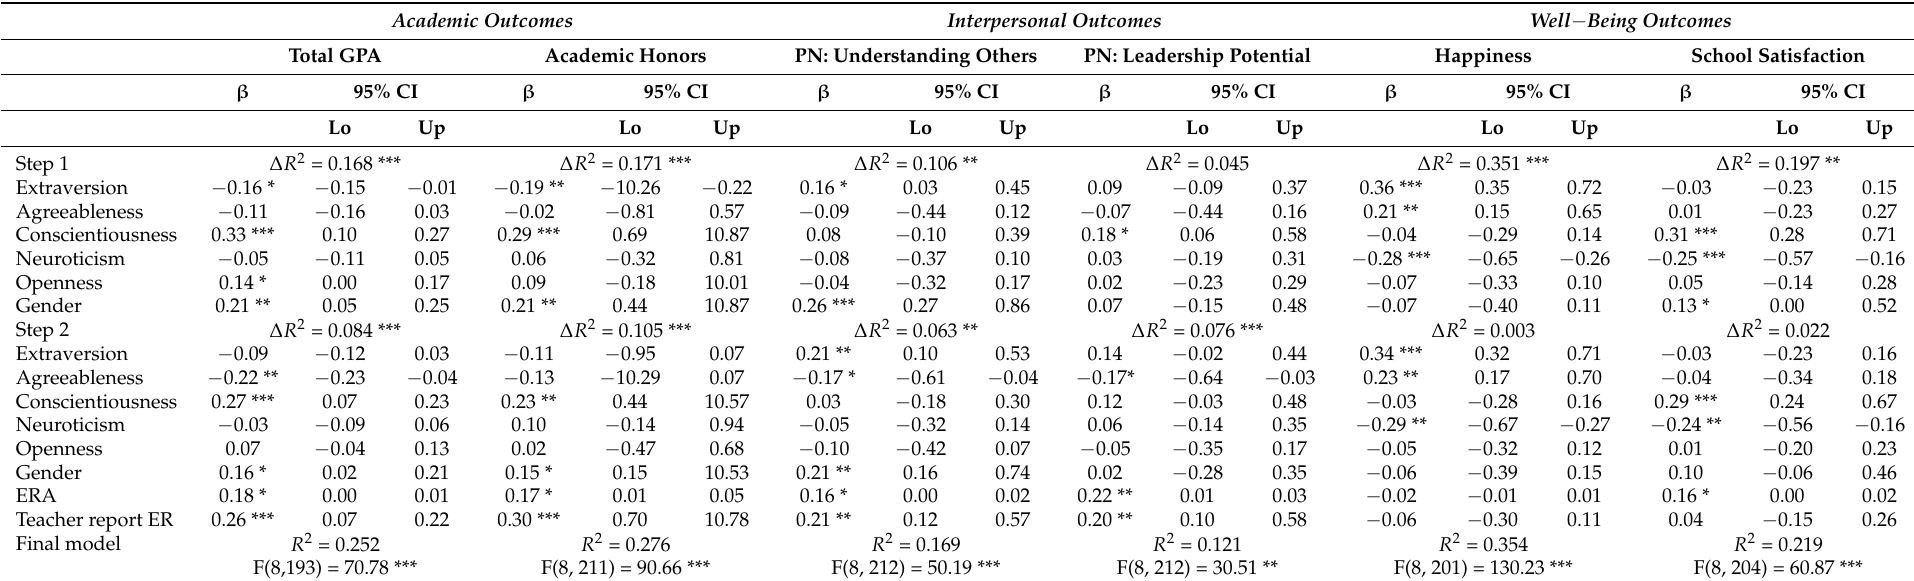
Table 2. Multiple regression variables predict academic, interpersonal, and well-being outcomes while controlling for Big Five. Academic Outcomes Interpersonal Outcomes Well − Being Outcomes Total GPA Academic Honors PN: Understanding